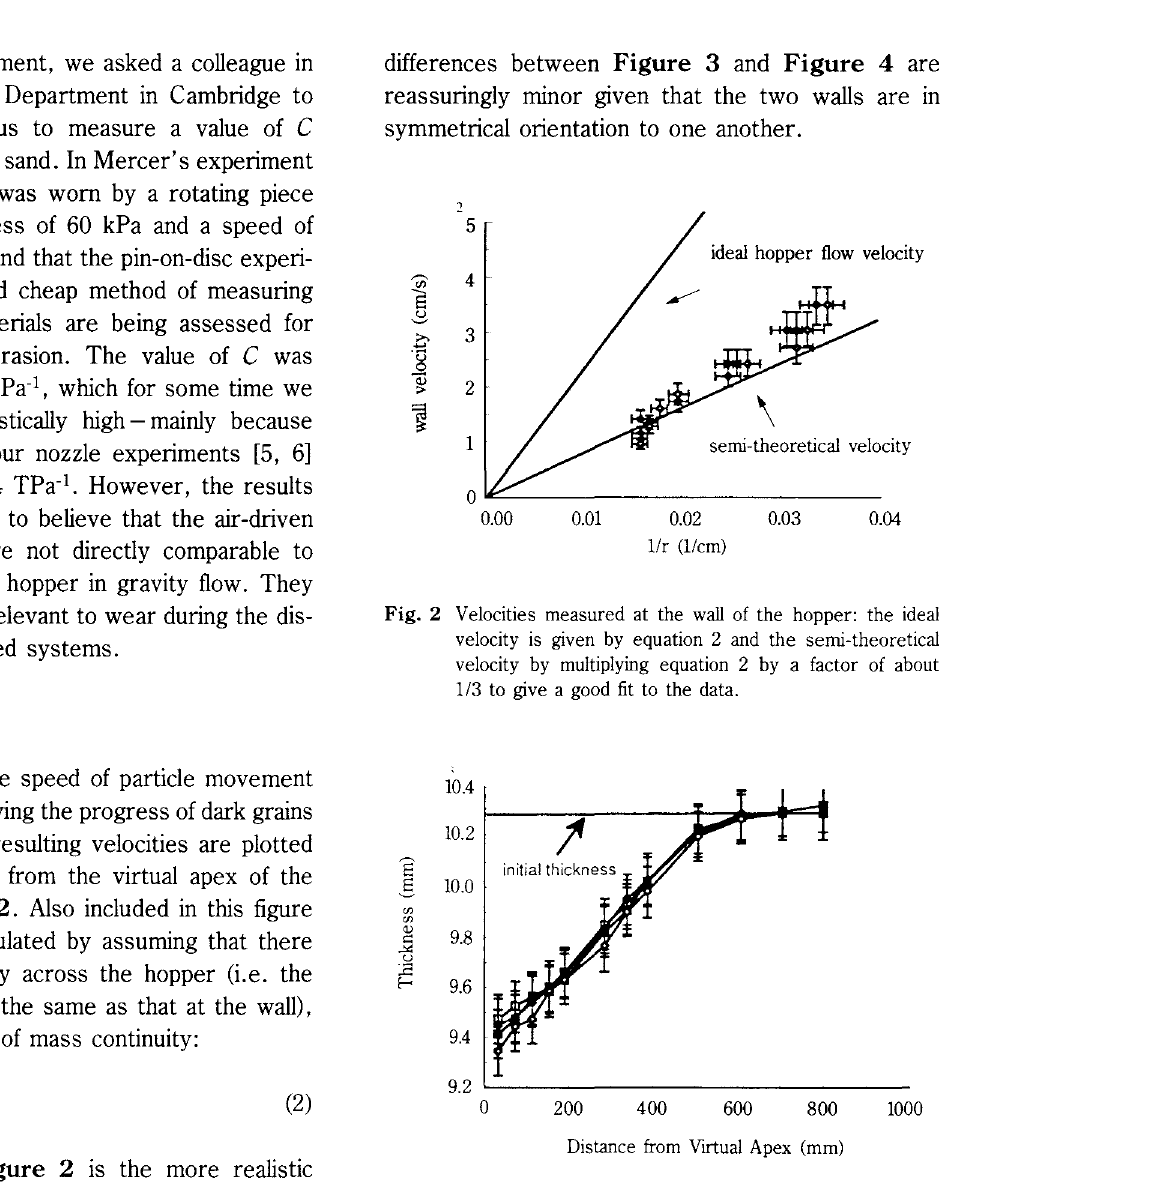
Fig. 3 Measured wear at right-hand wall